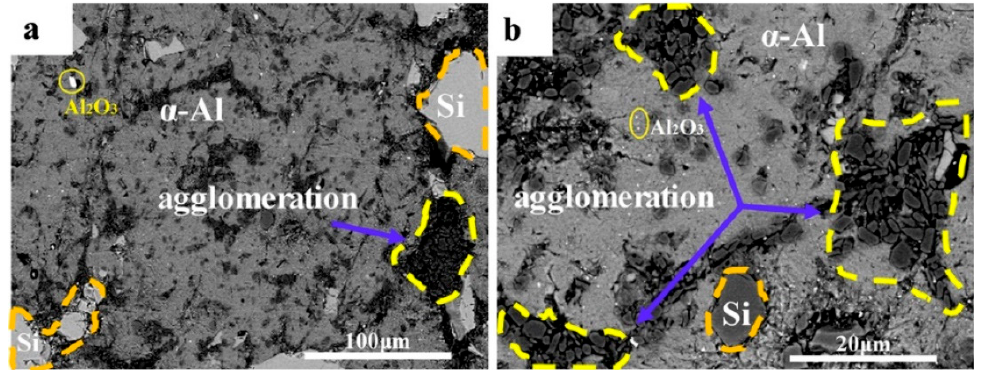
Figure 2. Scanning Electron Microscopy (SEM) microstructures of Al 2 O 3 /Al-20Si composite under 0.02 GPa ( a ) 100 times, ( b ) 500 times. Table 1. Electron Diffraction Spectrum (EDS) analysis of matrix phase and black phase of Al 2 O 3 /Al-20Si composites. Phase Matrix Bulk grey phase White